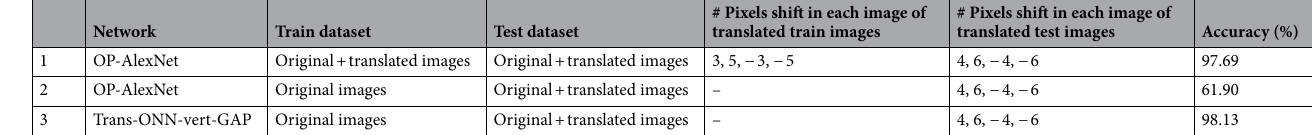
Table 5. Comparison of OP-AlexNet against